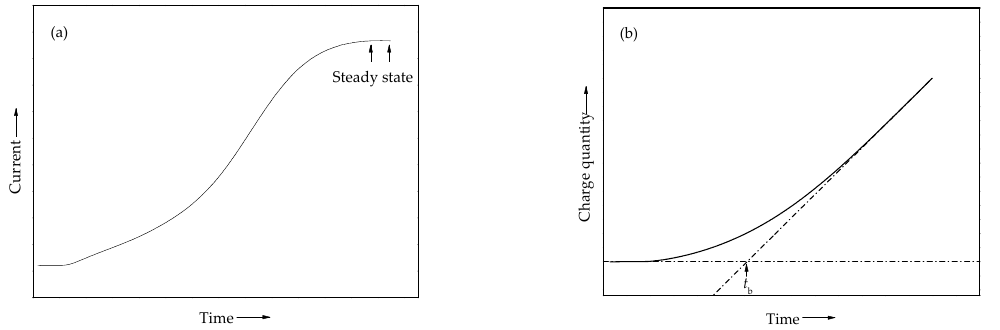
Figure 1. Typical hydrogen permeation curves ( a ) I - t curve; ( b ) Q - t curve.